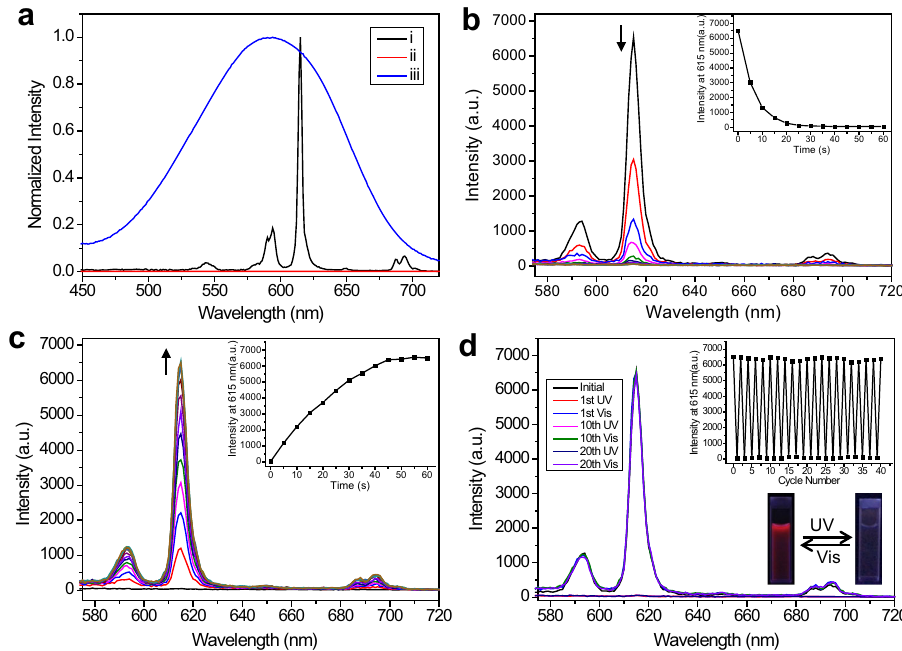
Fig. 4 Photophysical studies. a Partial emission spectrum (black curve) of Eu 3 + - L , and absorption spectra of OF- 1 (red curve) before and (blue curve) after irradiation with 300 nm UV light for 60 s. b , c Luminescence emission spectral changes of Eu 3 + - L -OF- 1 upon ( b ) UV light (300 nm) irradiation and c subsequent visible light (>450 nm) irradiation in water. Insets show corresponding emission intensity changes at 615 nm. d Luminescence emission changes of Eu 3 + - L -OF- 1 upon consecutive alternating exposure to UV and visible light. Insets show corresponding intensity changes at 615 nm (upper) and the photographs of the SCP solution under 254 nm UV lamp (lower). [Eu 3 + ] = 1.4 × 10 − 4 M, [ L ] = [OF - 1 ] = 2.1 × 10 − 4